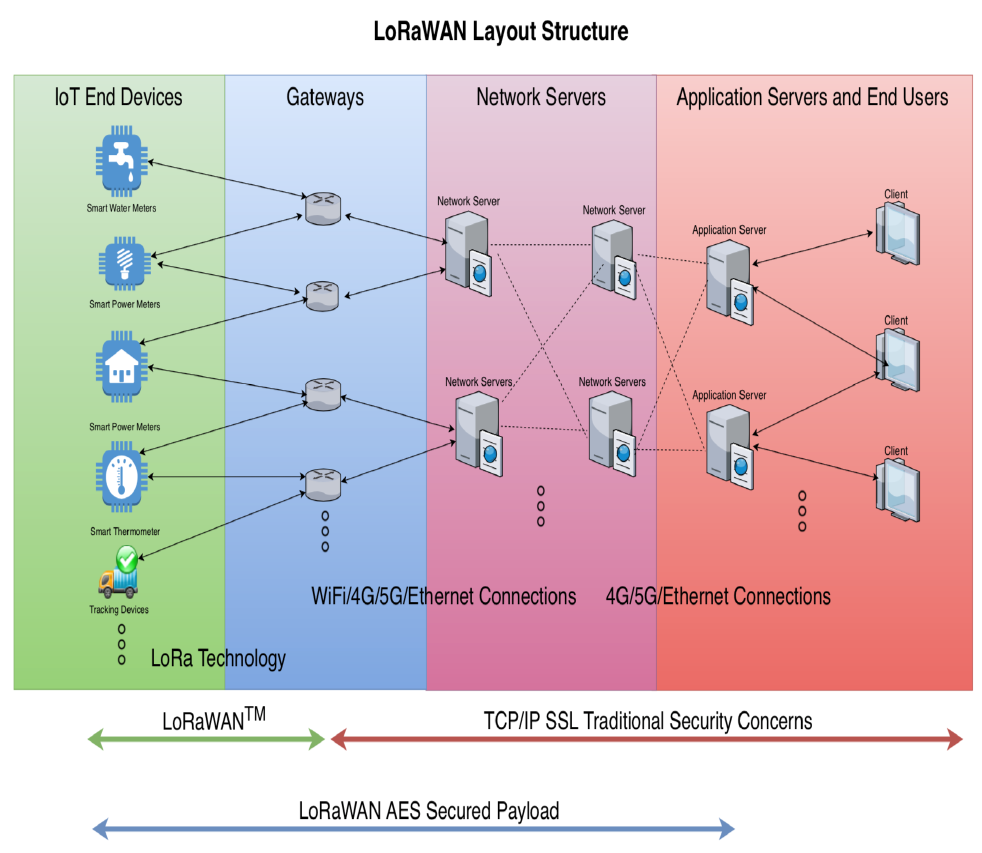
Figure 1. The layout of the LoRaWAN